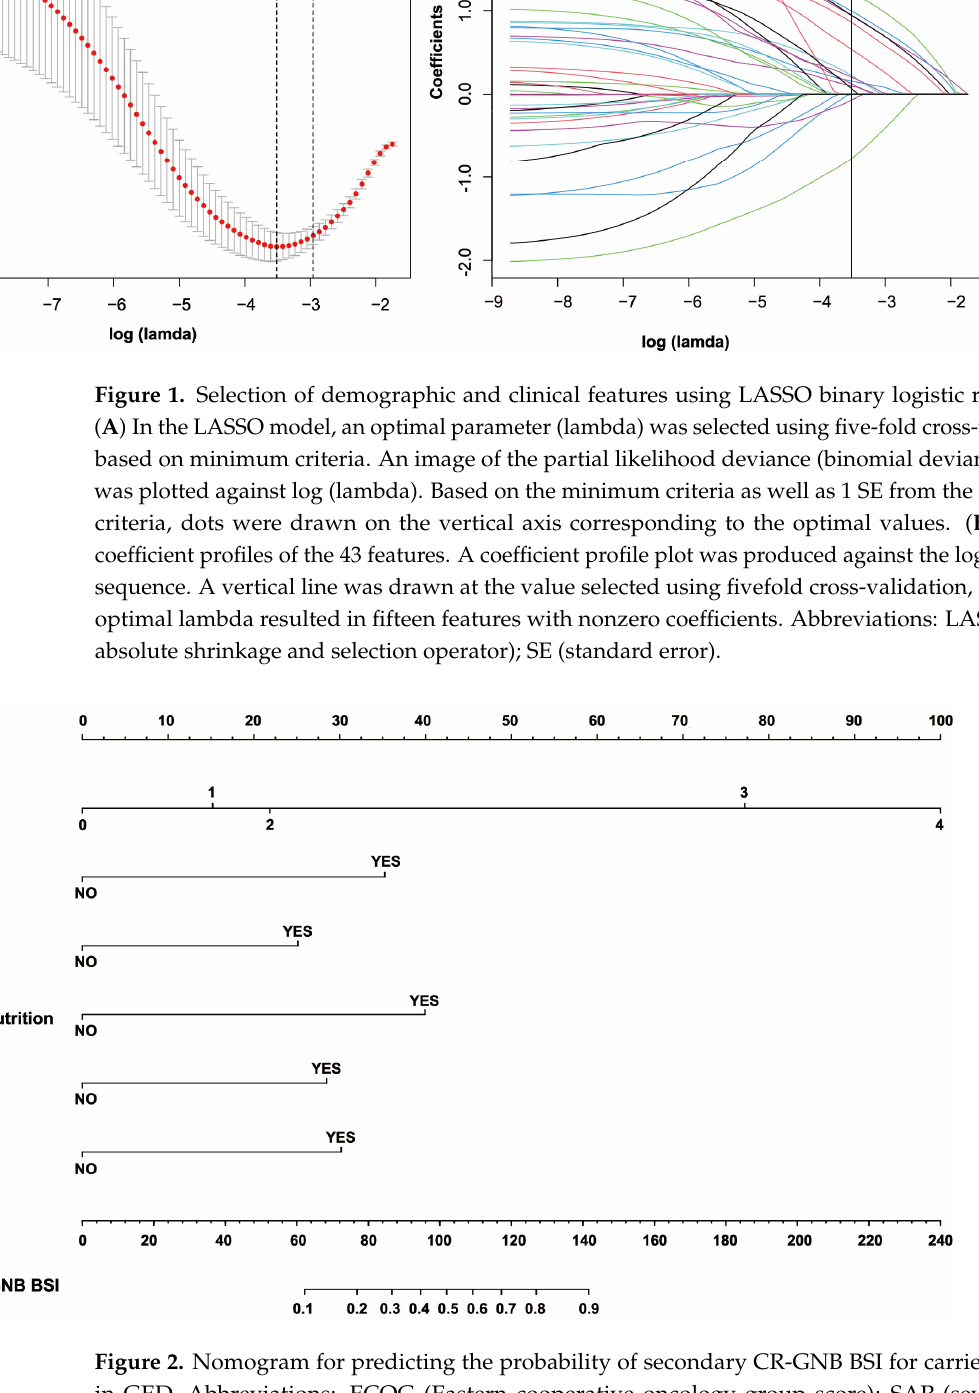
Figure 1. Selection of demographic and clinical features using LASSO binary logistic regression. ( A ) In the LASSO model, an optimal parameter (lambda) was selected using five-fold cross-validation based on minimum criteria. An image of the partial likelihood deviance (binomial deviance) curve was plotted against log (lambda). Based on the minimum criteria as well as 1 SE from the minimum criteria, dots were drawn on the vertical axis corresponding to the optimal values. ( B ) LASSO coef- ficient profiles of the 43 features. A coefficient profile plot was produced against the log (lambda) sequence. A vertical line was drawn at the value selected using fivefold cross-validation, where the optimal lambda resulted in fifteen features with nonzero coefficients. Abbreviations: LASSO (least absolute shrinkage and selection operator); SE (standard error).